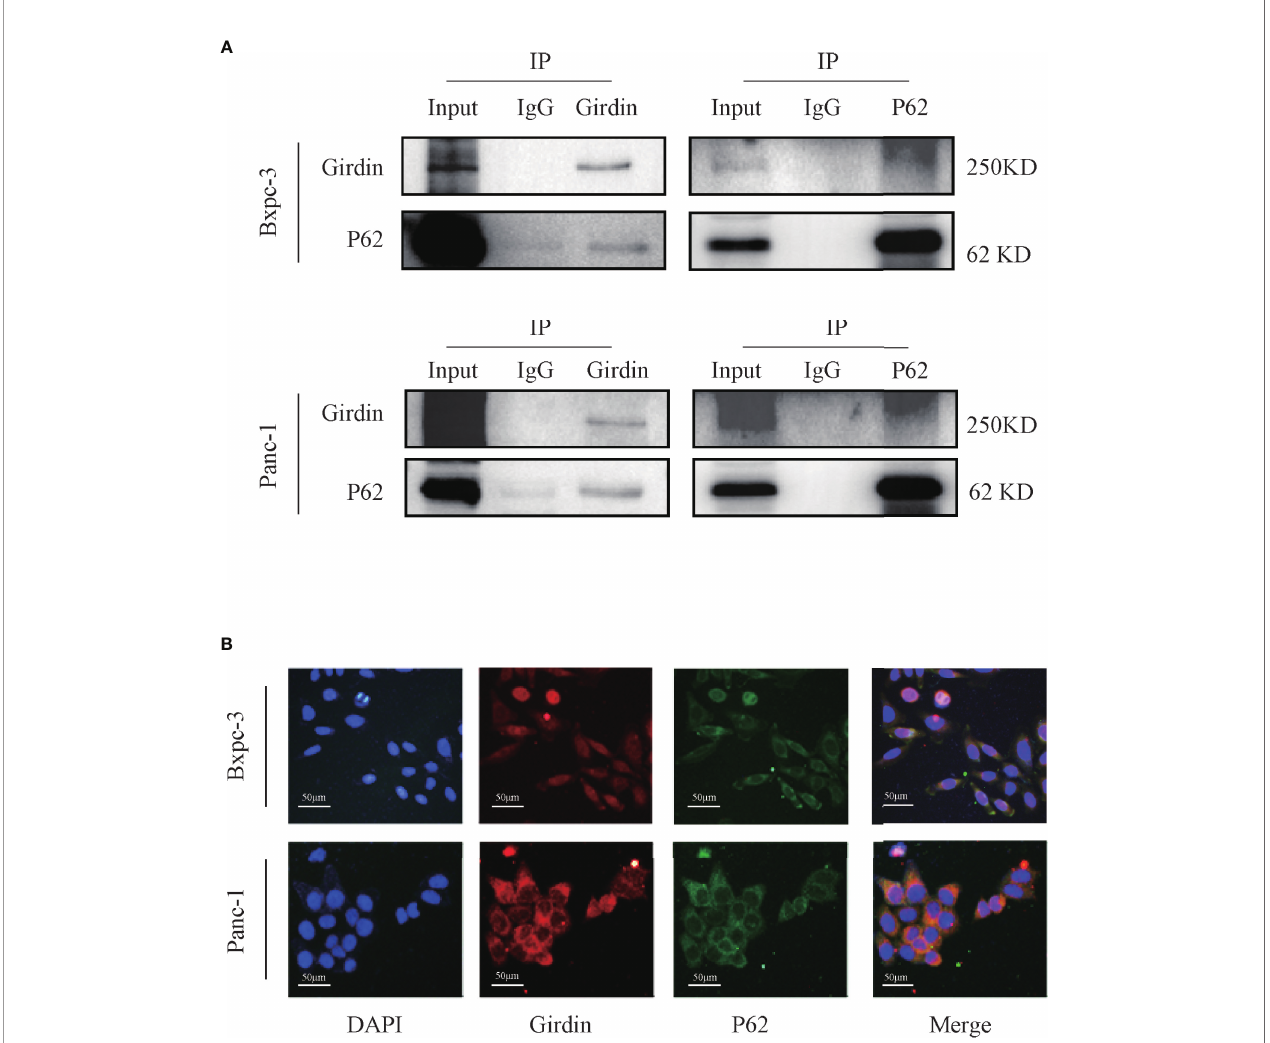
FIGURE 4 | Girdin interacts with autophagy protein P62/SQSTM1 in pancreatic cancer cells. (A) The interaction between Girdin and P62 was detected in the co-IP analysis Bxpc-3 and Panc-1 cells. The binding signals of P62 with Girdin were also con fi rmed using anti-Girdin antibodies in IPs, and subsequent blotting with P62 antibodies. (B) The expressions of Girdin and P62 were endogenous and immuno fl uorescence staining images showed a signi fi cant physically interacted with each other in the cytoplasm. Red represents Girdin, green represents P62, and the nuclei were labelled with